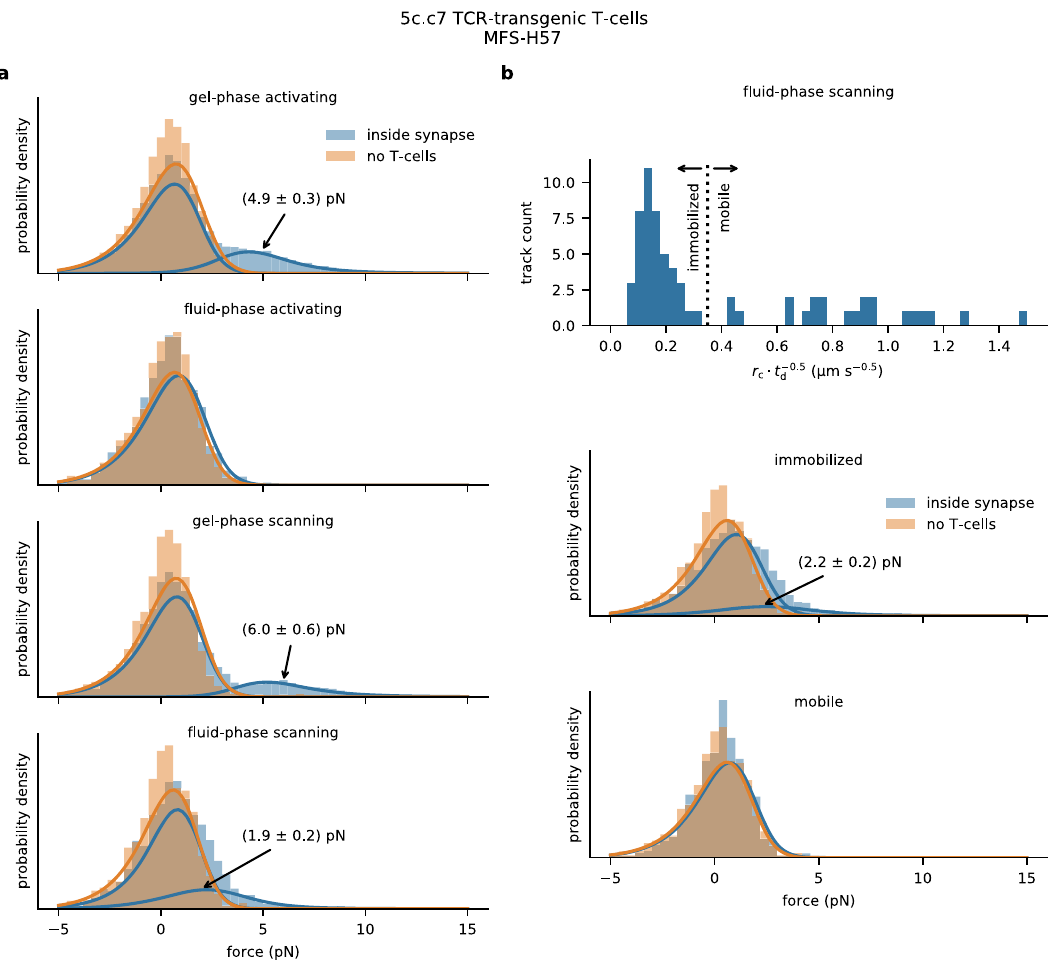
Fig. 2 Single-molecule pulling forces exerted via individual TCRs on the H57-functionalized molecular force sensor. a Single-molecule TCR-imposed forces determined within synapses of activated or scanning T-cells confronted with gel-phase (DPPC) or fl uid-phase (POPC) SLBs. Experiments were performed on 5c.c7 T-cells using sensors functionalized with H57. A high force peak emerged for activated or scanning T-cells confronted with gel-phase SLBs at F = 4.9 ± 0.3 pN and F = 6.0 ± 0.6 pN, which corresponded to 21% and 15% of observed events, respectively. For T-cells scanning fl uid-phase SLBs we observed an additional high force peak at F = 1.9 ± 0.2 pN with 25% weight. n = 15,556 (593 movies, each containing ≥ 1 cell) for MFS on gel-phase SLBs in contact with activated T-cells, n = 12,657 (195 movies) for MFS on fully stimulatory gel-phase without T-cells, n = 6006 (453 movies) for MFS on gel-phase SLBs including scanning T-cells, n = 5502 (165 movies) for MFS on gel-phase SLBs (non-stimulatory) without T-cells, n = 1161 (293 movies) for MFS on fl uid-phase interacting with activated T-cells, n = 1528 (90 movies) for MFS on stimulatory fl uid-phase without T-cells, n = 2147 (333 movies) for MFS on fl uid-phase SLBs in contact with scanning T-cells, n = 1796 (70 movies) for MFS on non-stimulatory fl uid-phase without T-cells. b Bound MFS were distinguished from unbound MFS on fl uid-phase SLBs under scanning conditions by means of the single molecule mobility as described in Supplementary Fig. 8. The dashed line indicates the chosen boundary drawn between mobile and immobilized MFS. Unbound MFS (termed “ mobile ” ) gave rise to a force distribution showing no signi fi cant difference from the control scenario recorded without T-cells. Bound MFS (termed “ immobilized ” ) featured a high-force shoulder similar to Fig. 2a, fourth